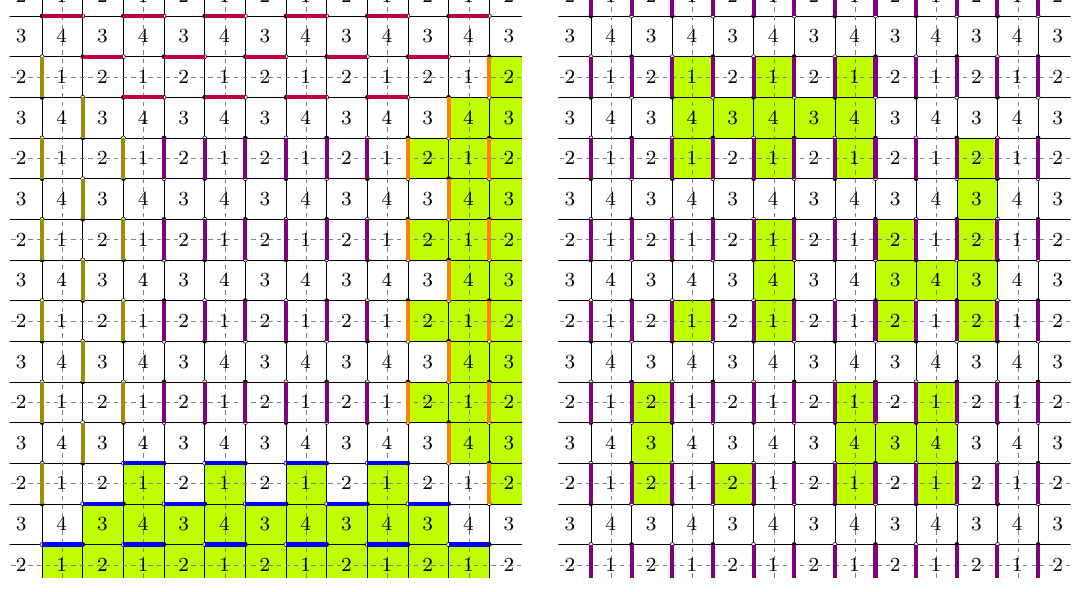
Figure 7 . Left: “Unbounded” rotations, changing ( N, M ) ( N, M + 1) . Right: different types of rotation possible in the central region, which are freezing out in tropical limit. The weights of rotations shown on picture by lime color